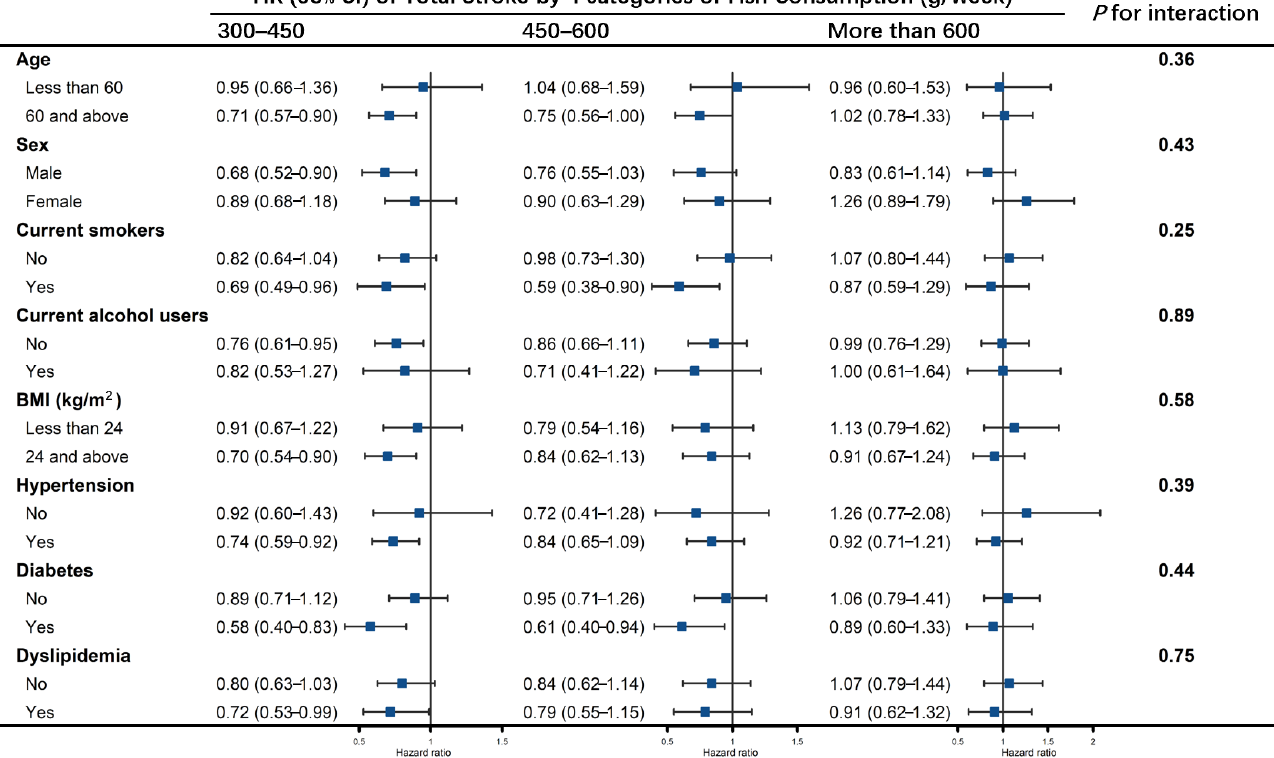
Figure 3. Association of fish consumption (g/week) between the risk of total stroke by subgroups of age, sex, smoking status, alcohol drinking status, BMI groups, history of hypertension, diabetes, and dyslipidemia. The model was adjusted for age, sex, educational levels, marital status, retirement status, smoking status, alcohol drinking status, physical activity levels, sleep qualities, obesity status, dietary energy intakes, consumption of fruit, vegetables, peanuts, wholegrains, processed and unprocessed meats, bean products, salt and oil, histories of chronic diseases, including hypertension, CHD, diabetes, CKD, dyslipidemia, HUA, HHcy, COPD, chronic bronchitis and asthma (the same as covariates in Model 3). Each subgroup analysis was adjusted for all the covariates listed above except itself.